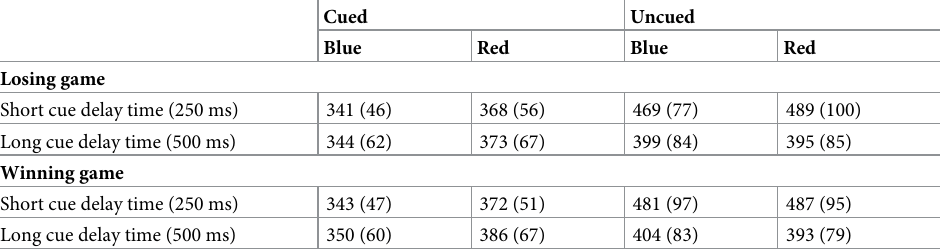
Table 4. Mean reaction times and standard deviations of the spatial oriental task in the prospective sample (n = 91). Cued